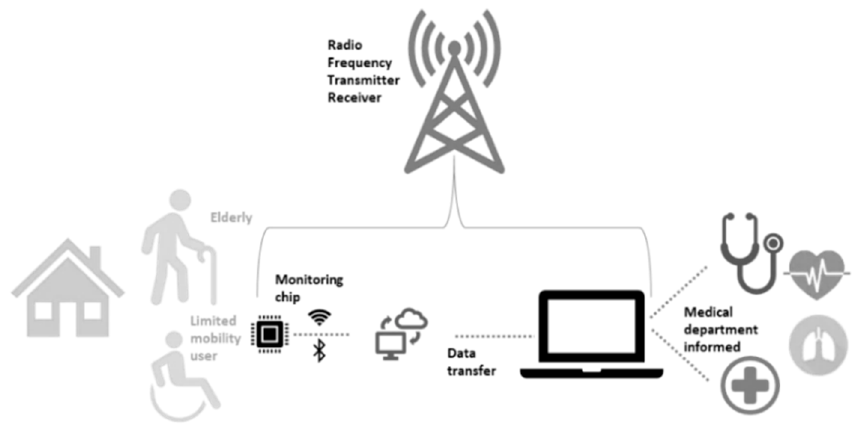
Figure 8. Block diagram example of a medical wearable’s process.